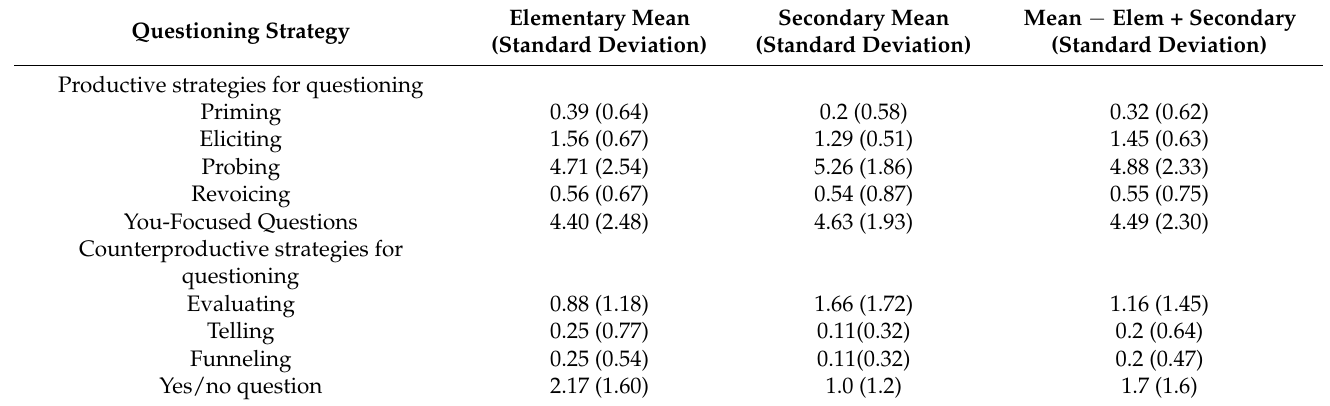
Table 5. Mean frequency of questioning strategy codes by conversation.